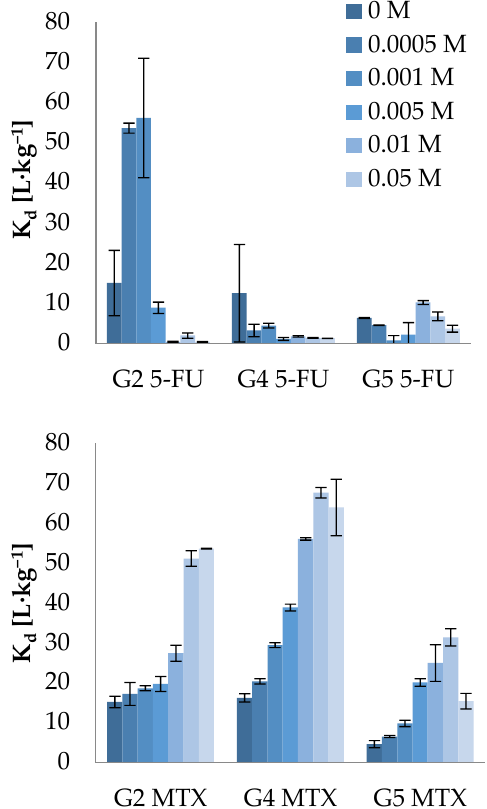
Figure 4. The influence of ionic strength on the sorption potential of 5-FU and MTX (Basic conditions: concentration range of CaCl 2 : from 0, to 0.1 M; concentration level of ADs: 5 µ g · mL − 1 ; adsorption equilibrium time: 24 h; optimal S/L ratio: 5-FU (G2 soil = 1:25; G4 and G5 soil = 1:5); MTX (G2, G4, G5 soil = 1:15).